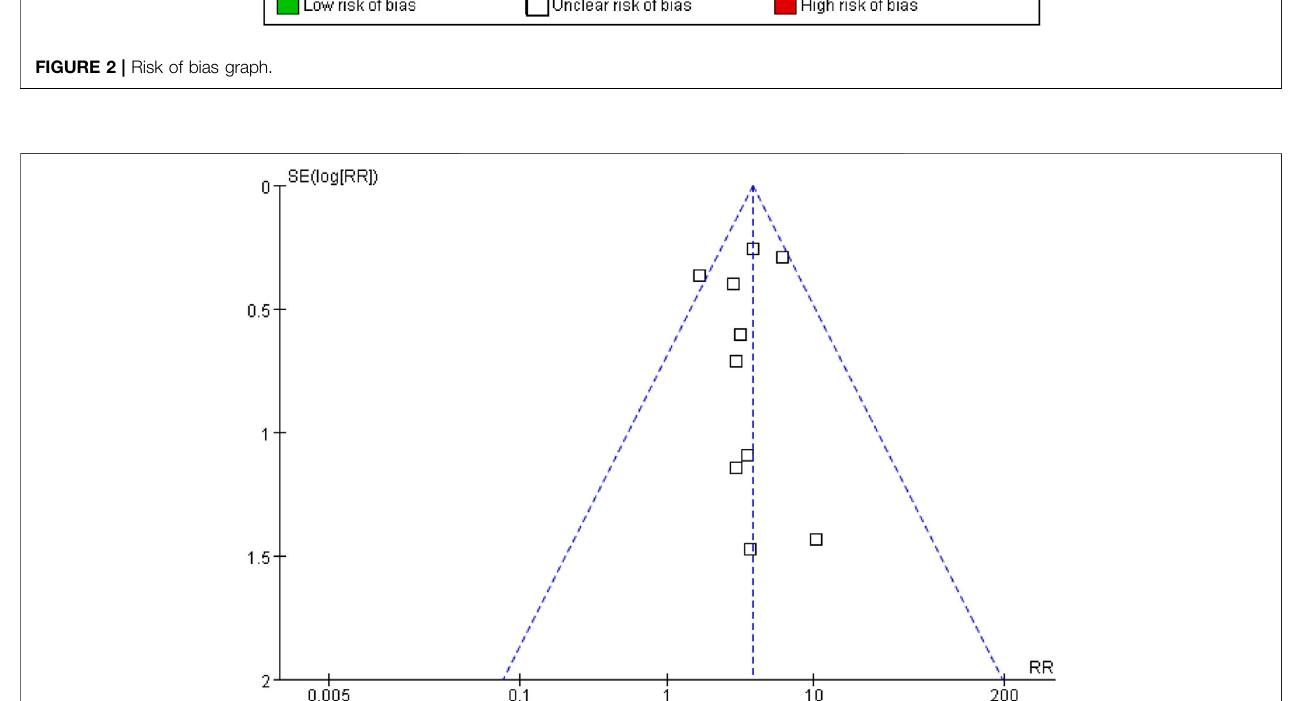
FIGURE 3 | Publication bias based on